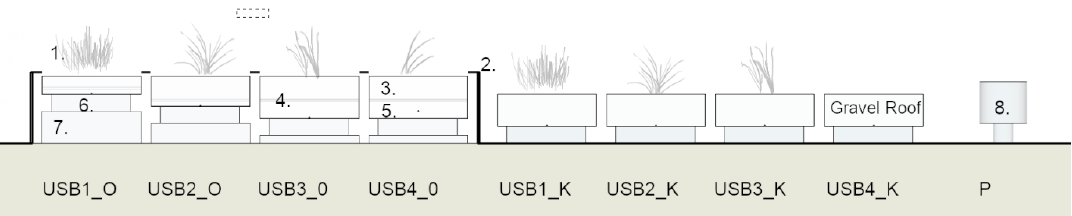
Figure 5. The small-scale lysimeter station was located on a green roof in Neubrandenburg, Germany. The frame was used to minimize the effects of wind and radiation on the experimental plots. Legend: (1) Vegetation, (2) frame, (3) soil, (4) drainage layer, (5) retention box, (6) scale, (7) substructure, and (8) ombrometer (Table 2).